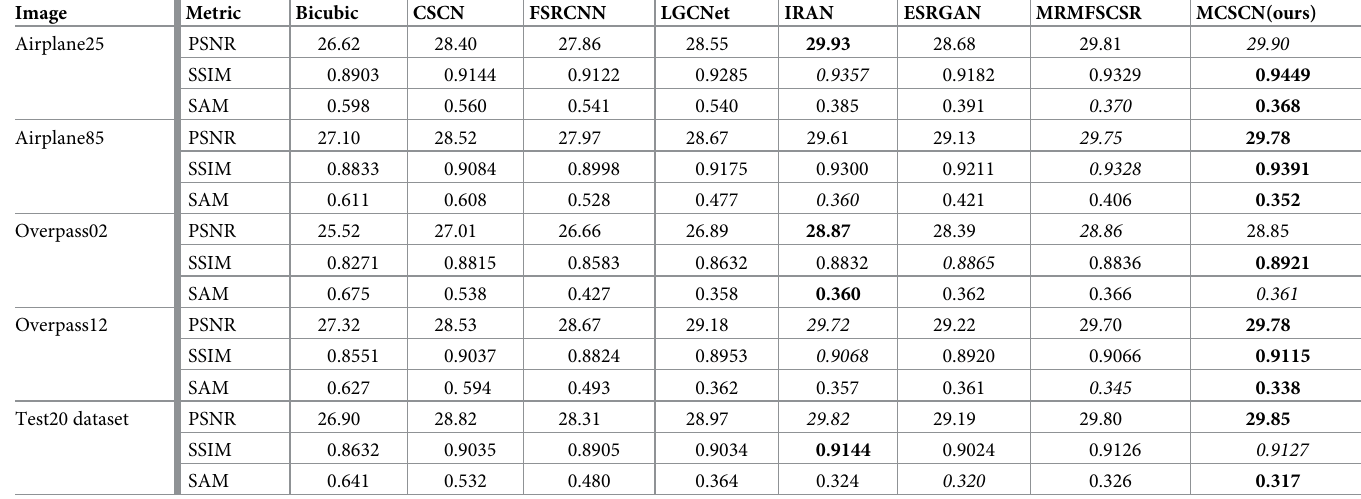
Table 3. PSNR/SSIM comparison on remote sensing test datasets among different methods with up-scaling factor × 4. Boldface indicates the best performance and ital- ics indicate the second-best performance.